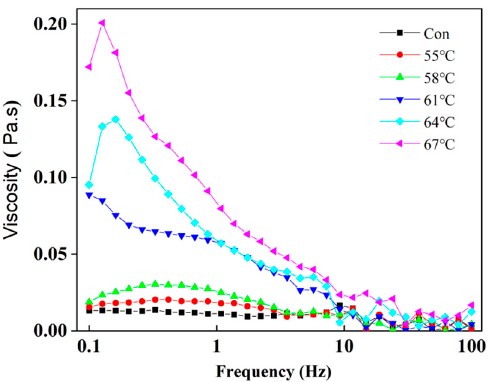
Figure 6. The ffect of different heating treatment conditions on the rheological properties of LWE. The “Con” in figure refers to control group.